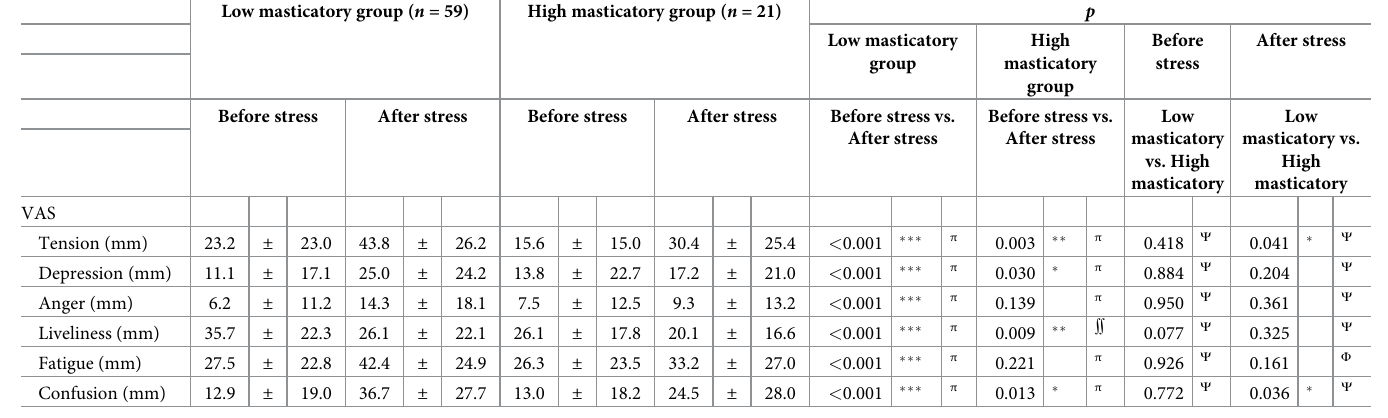
Data are expressed as mean ± standard deviation.